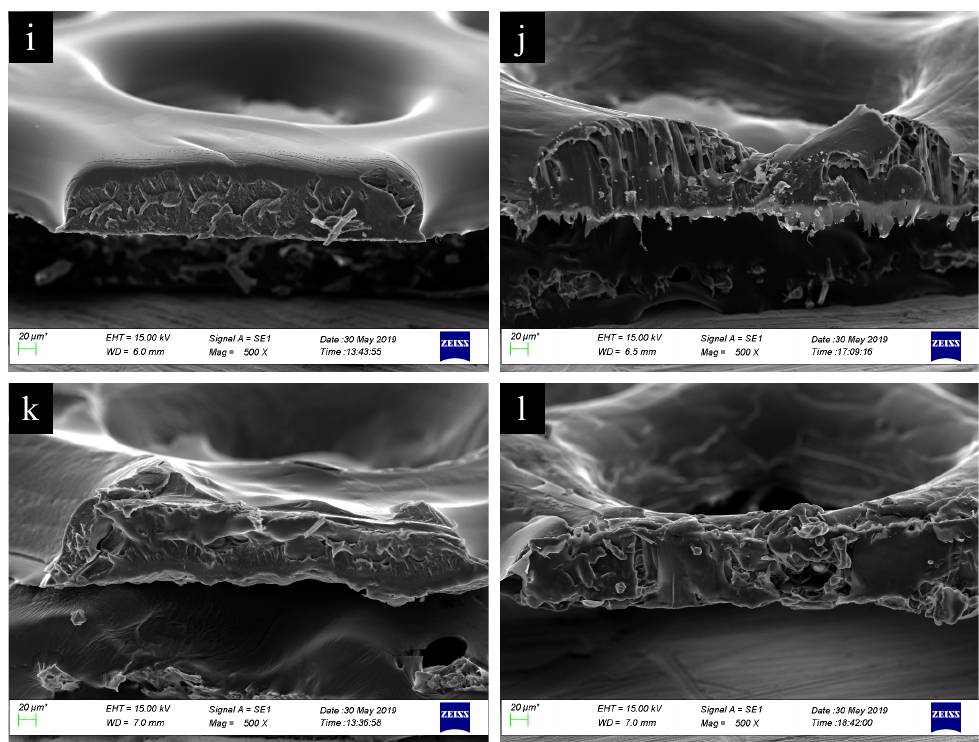
Figure 2. SEM images of ( a,i ) PCL/GEL, ( c,j ) PCL/GEL/BC, ( e,k ) PCL/GEL/BC/0.25%HA, ( g,l ) PCL/GEL/BC/0.50%HA scaffolds and pore size histiograms of ( b ) PCL/GEL, ( d ) PCL/GEL/BC, ( f ) PCL/GEL/BC/0.25%HA and h ) PCL/GEL/BC/0.50%HA scaffolds.